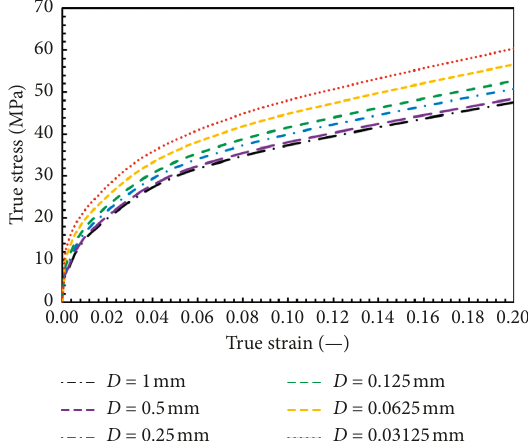
Figure 4: True stress-true strain responses with varying grain sizes from